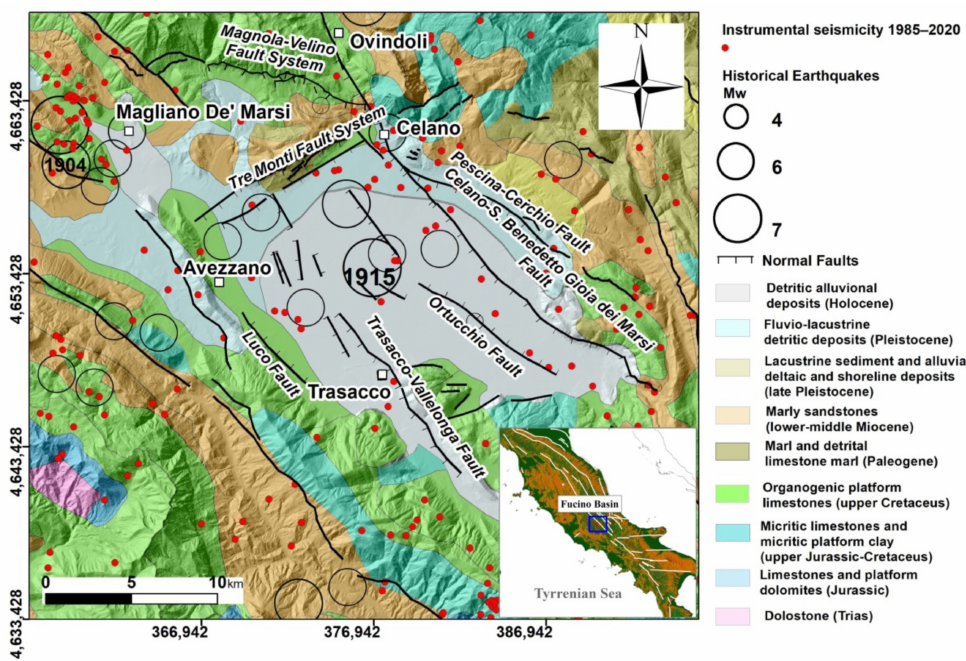
Figure 1. The area of our study: map of the Fucino basin. The system of normal faults is from [2]; the historical earthquakes since 1000 A.D. are from [11] (black boxes); the instrumental seismicity is from the ISIDE database [27] (red circles). Geological map (modified from